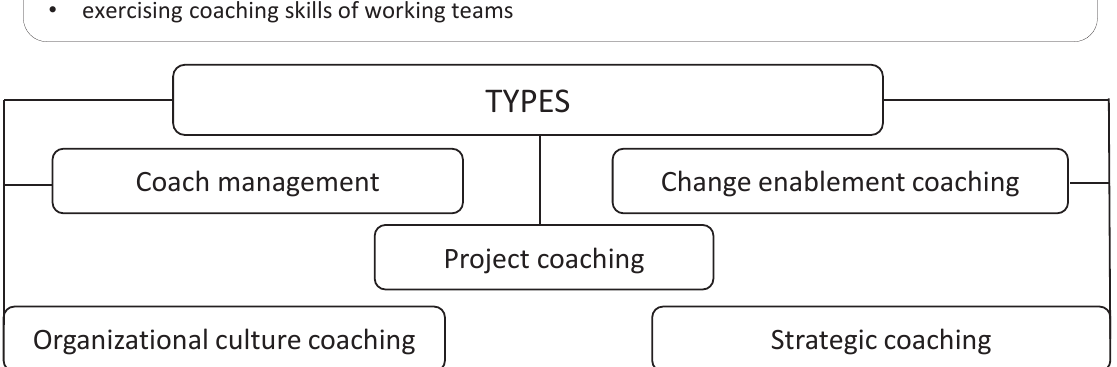
Figure 2. The scheme of implementing coaching as a tool for an enterprise development